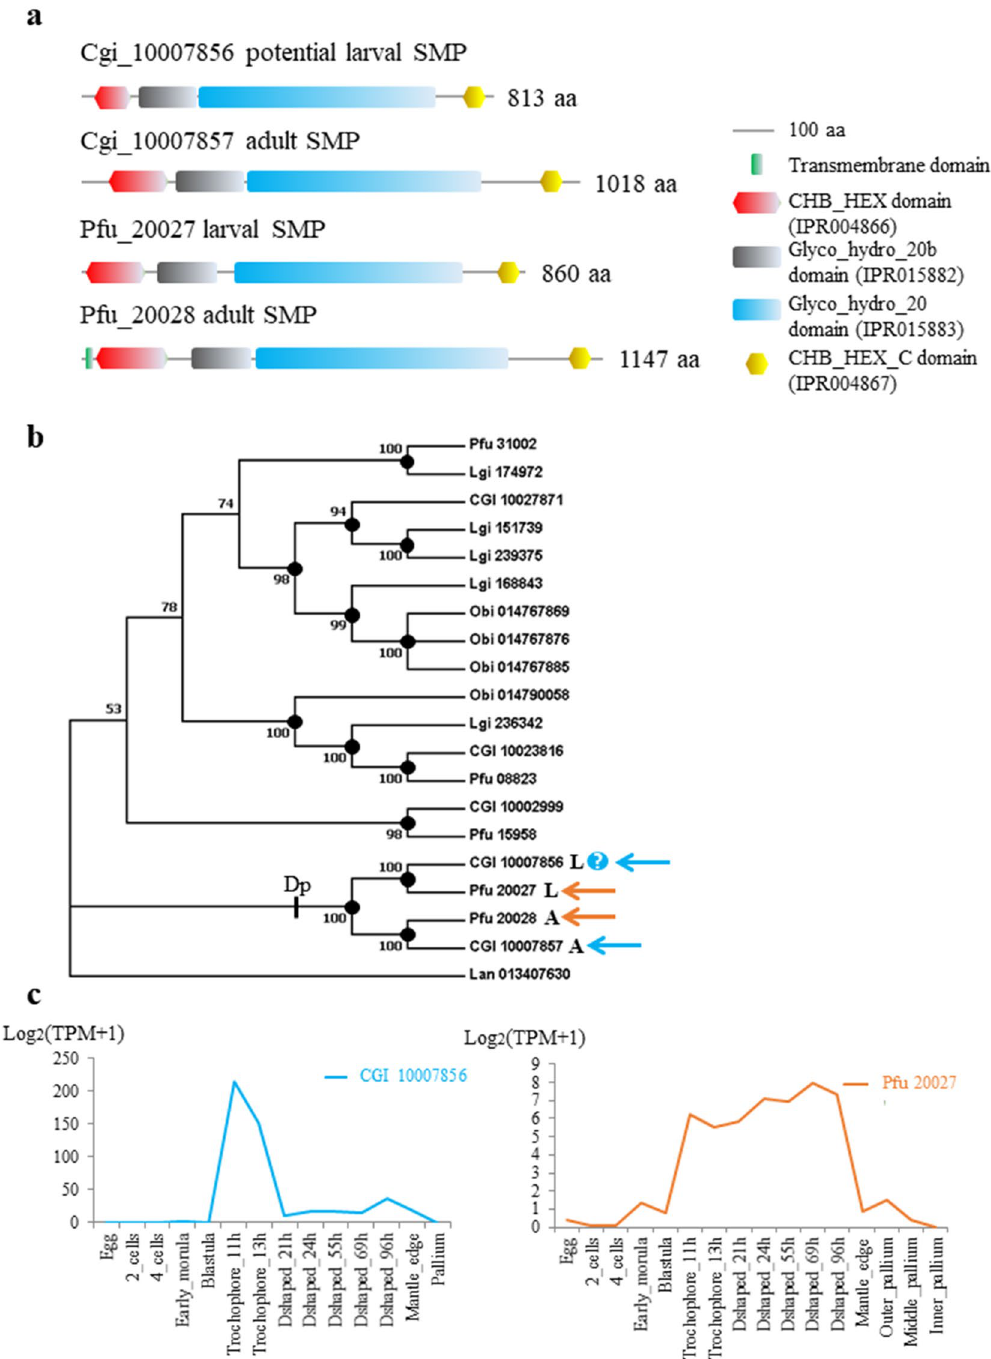
Figure 4. Phylogenetic analyses of chitobiases in molluscs on 1066 amino acid residues. ( a ) Schematic representations of the domain structures of chitobiases. ( b ) Bayesian phylogenetic estimation for chitobiases in molluscs using the concatenated sequences of CHB_HEX domain (IPR004866), Glyco_hydro_20b domain (IPR015882), Glyco_hydro_20 domain (IPR015883) and CHB_HEX_C domain (IPR004867). ( c ) Stage- specific expression of the larval chitobiase during development in C. gigas (blue) and P. fucata (orange) 13,39,59 . Polychotomy is generated if the posterior probability value of the node is < 50. Posterior probability values are shown if ≥ 50, and marked with black dots if ≥ 80. SMPs are indicated by blue ( C. gigas ) and orange ( P. fucata ) arrowheads. The question mark indicates that whether or not the gene is encoding an SMP is uncertain. Cgi, Crassostrea gigas ; Pfu, Pinctada fucata ; Lgi, Lottia gigantea ; Obi , Octopus bimaculoides. Lan, Lingular anatina ; Dp,